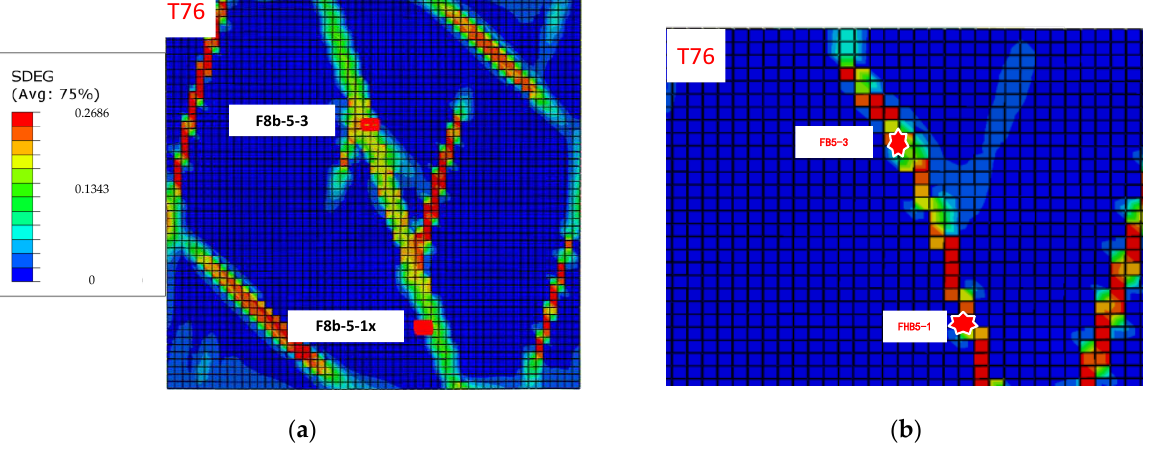
Figure 9. Contours of SDEG at T76 interface: ( a ) numerical results of submodel and ( b ) results of global model for the same region.